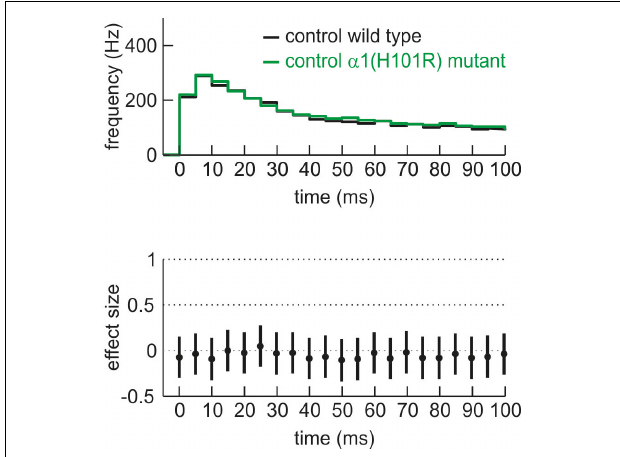
FIGURE 3 | Comparison of neuronal activity of cultured cortical neurons derived from wild type (black) and α 1(H101R) mutant mice (green) given as PETH and corresponding effect size for the first 100 ms of neuronal up state. There is no difference in neuronal activity under control conditions between wild type and α 1(H101R) mutant cortical circuits.